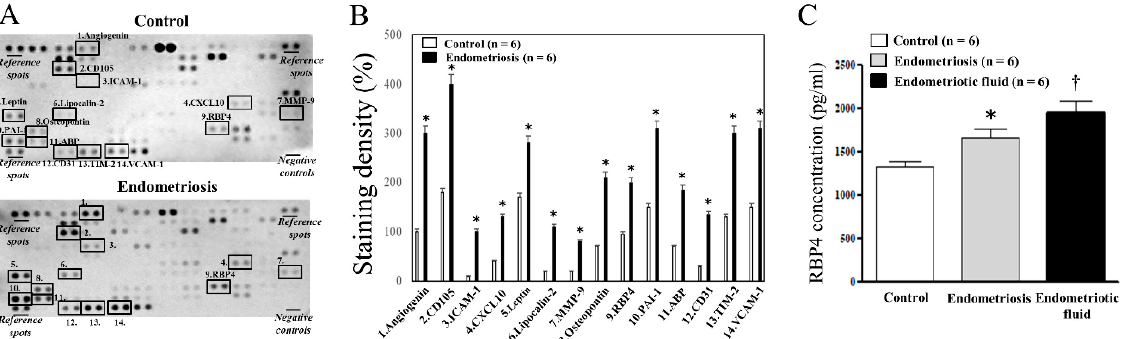
Figure 1. Human XL proteome profile constructed from the peritoneal fluids (PFs) of women with and without endometriosis ( A , B ) and RBP4 levels analyzed with ELISA assay ( C ). CD105, cluster of differentiation 105; ICAM-1, inter-cellular adhesion molecule 1; CXCL10, chemokine (C-X-C motif) ligand 10; MMP-9, matrix metallopeptidase 9; RBP4, retinol binding protein 4; PAI-1, plasminogen activator inhibitor-1; ABP, α -amino-3-hydroxy-5-methyl-4-isoxazolepropionic acid receptor binding protein; CD31, cluster of differentiation 31; TIM-2, thermal interface material 2; VCAM-1, vascular cell adhesion molecule 1. * p < 0.05 compared with the control group. † p < 0.05 compared with the control as well as the endometriosis